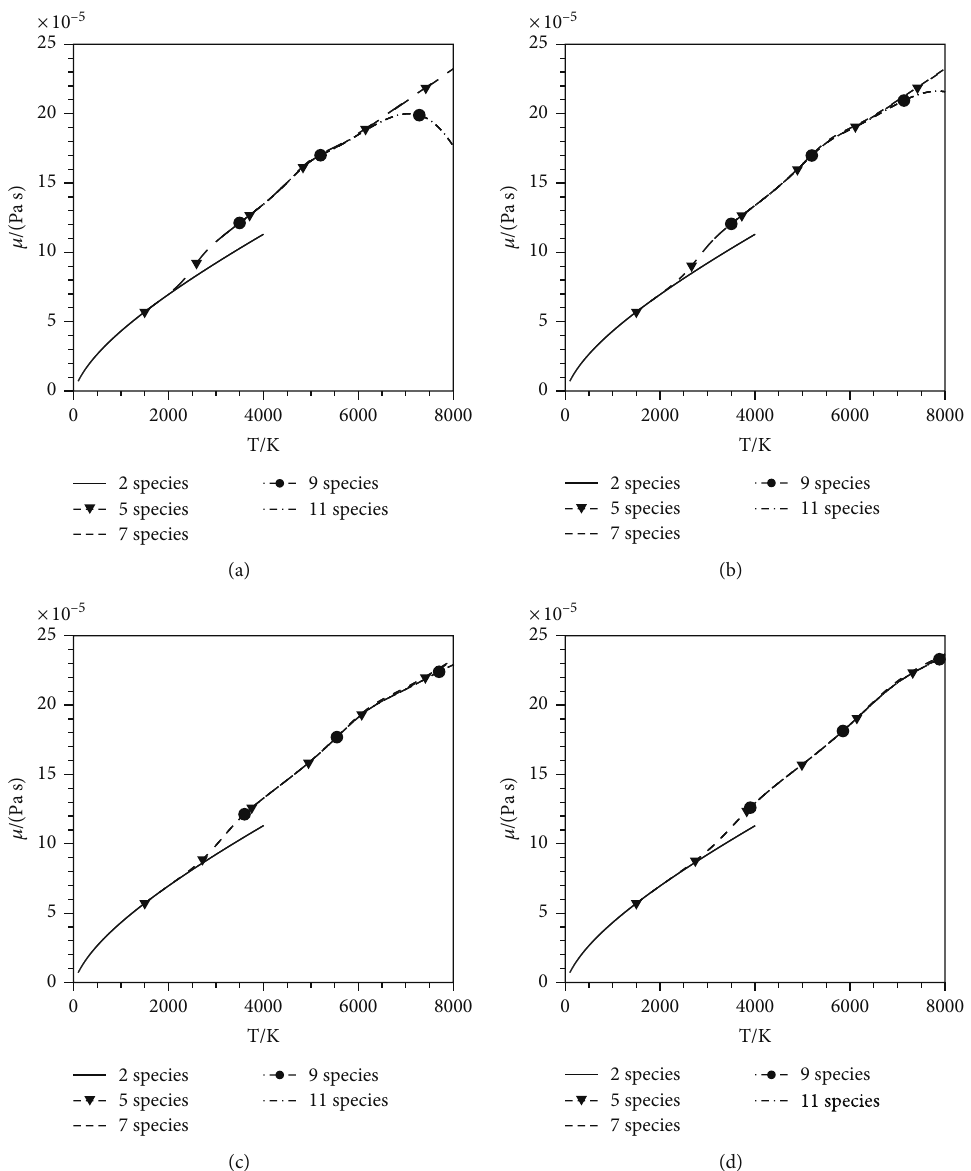
Figure 2: Viscosity coe ffi cients at di ff erent pressure conditions. (a) 0.001atm, (b) 0.01atm, (c) 0.1atm, and (d)